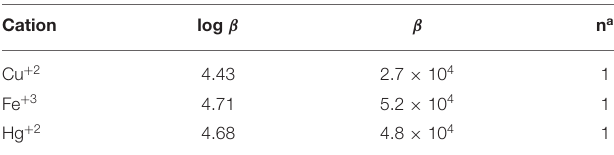
TABLE 2 | Binding constants of 2 with Cu + 2 , Fe + 3 , and Hg + 2 ions in CHCl 3 at 298K. Cation log β β n a Cu + 2 4.43 2.7 × 10 4 1 Fe + 3 4.71 5.2 × 10 4 1 Hg + 2 4.68 4.8 × 10 4